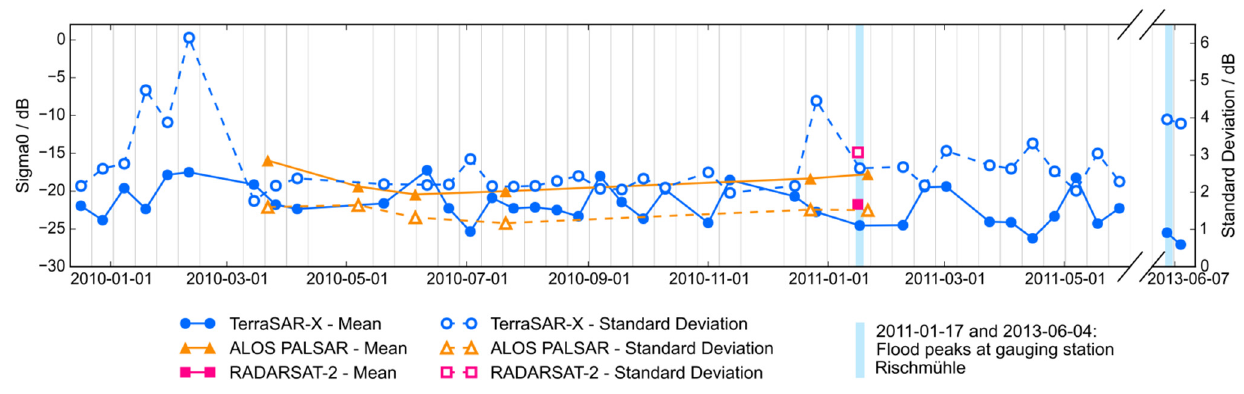
Figure 4. Time course of σ 0 (dB): Mean and standard deviation for test class 1 (Permanent water). The optimum threshold value to separate permanent water areas (class 1) and non-water areas (combined classes 3 and 5) of all data sets are computed based on the calculation of the Overall Accuracy (OA) for the backscatter range between − 40 to 0 dB ( Δ 0.25 dB). The mean optimum threshold value is − 13.4 dB for the X-band time series and − 14.3 dB for the L-band data. The high standard deviation of the optimum threshold value (2.3 for X-band, 2.2 for L-band) as well as the high variability of the backscatter shows that in water and flood detection applications, a threshold for separating water and non-water areas has to be set individually for each scene, especially for X-band data. Empirically predefined threshold values could lead to a significant misclassification of the water extent. Noticeable peaks of standard deviation around February 2010 and January 2011 are caused by partial ice cover of the permanent water bodies. Due to increased surface roughness, ice causes much stronger backscattering in comparison to smooth open water